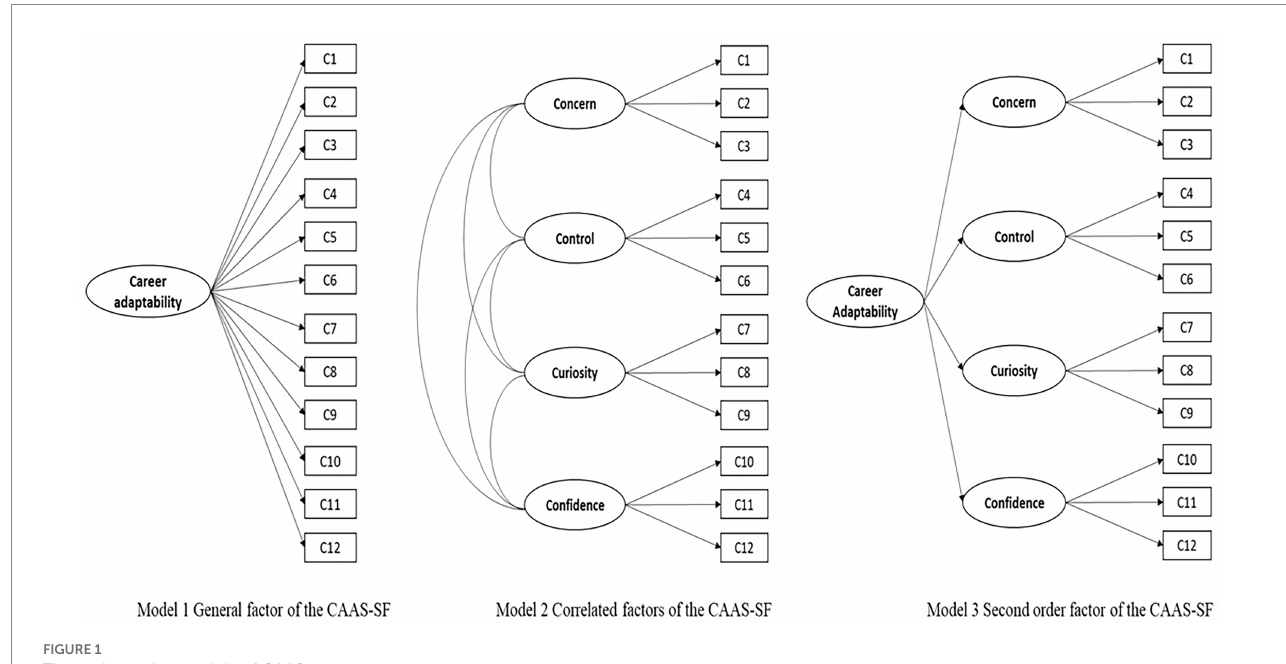
FIGURE 1 Three alternative models of